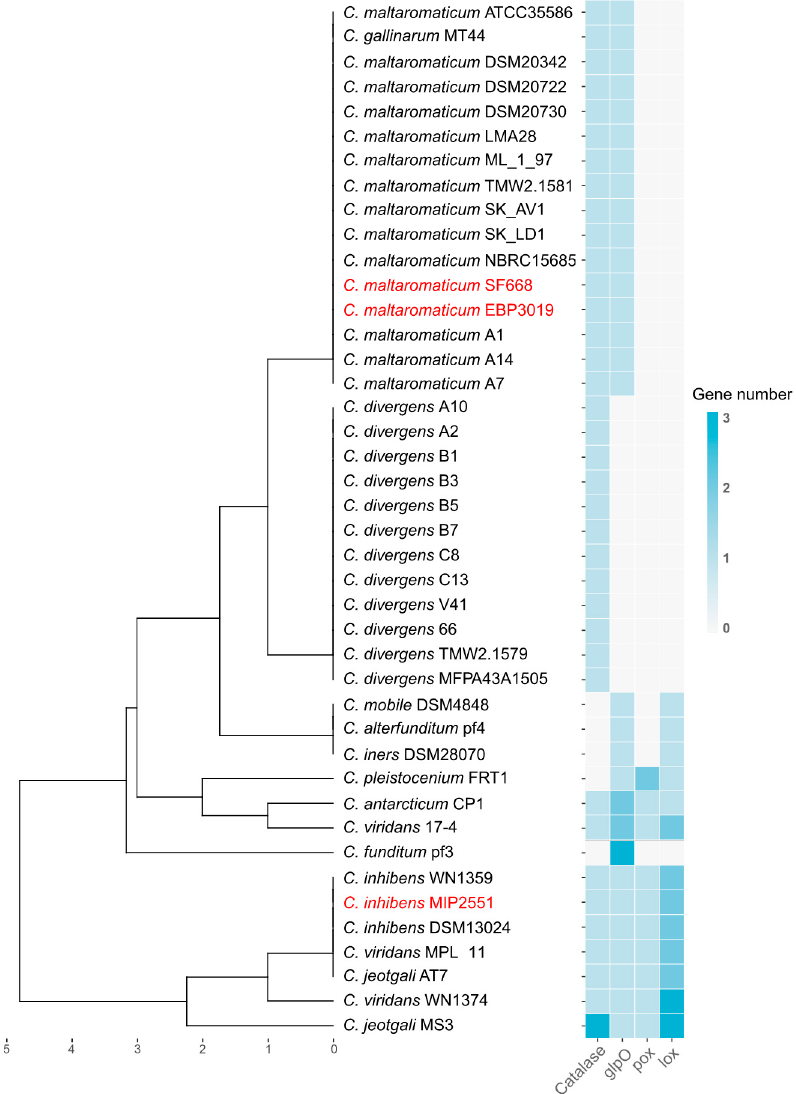
Figure 8. Hierarchical clustering of Carnobacterium spp. genomes by the presence of H 2 O 2 production and decomposition genes: Lactate oxidase ( lox , EC.1.13.12.4), pyruvate oxidase ( pox , EC.1.2.3.3), α -glycerophosphate oxidase ( glpO , EC.1.1.3.21), and catalase (EC.1.11.1.6). Genomes sequenced in this study are highlighted in